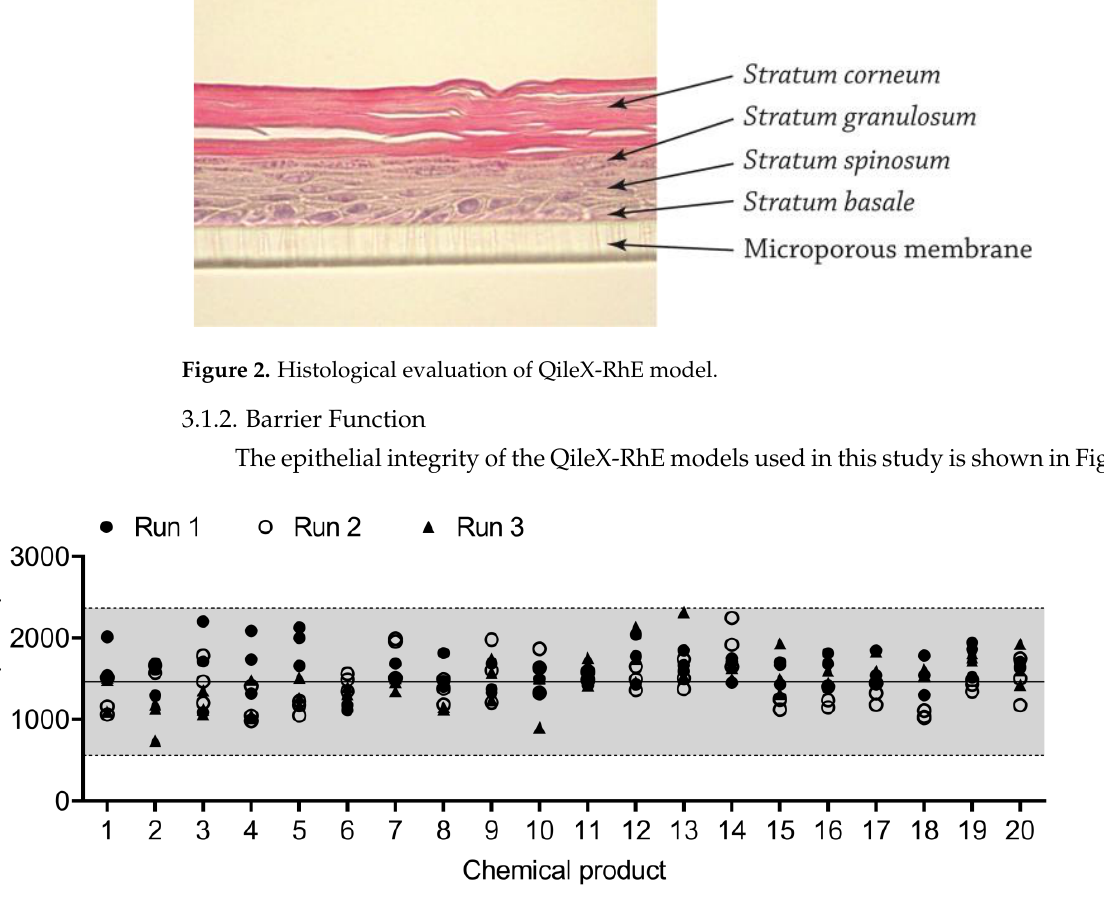
Table 2. Lipid composition of QileX-RhE, validated reference method and native epidermis. Lipids